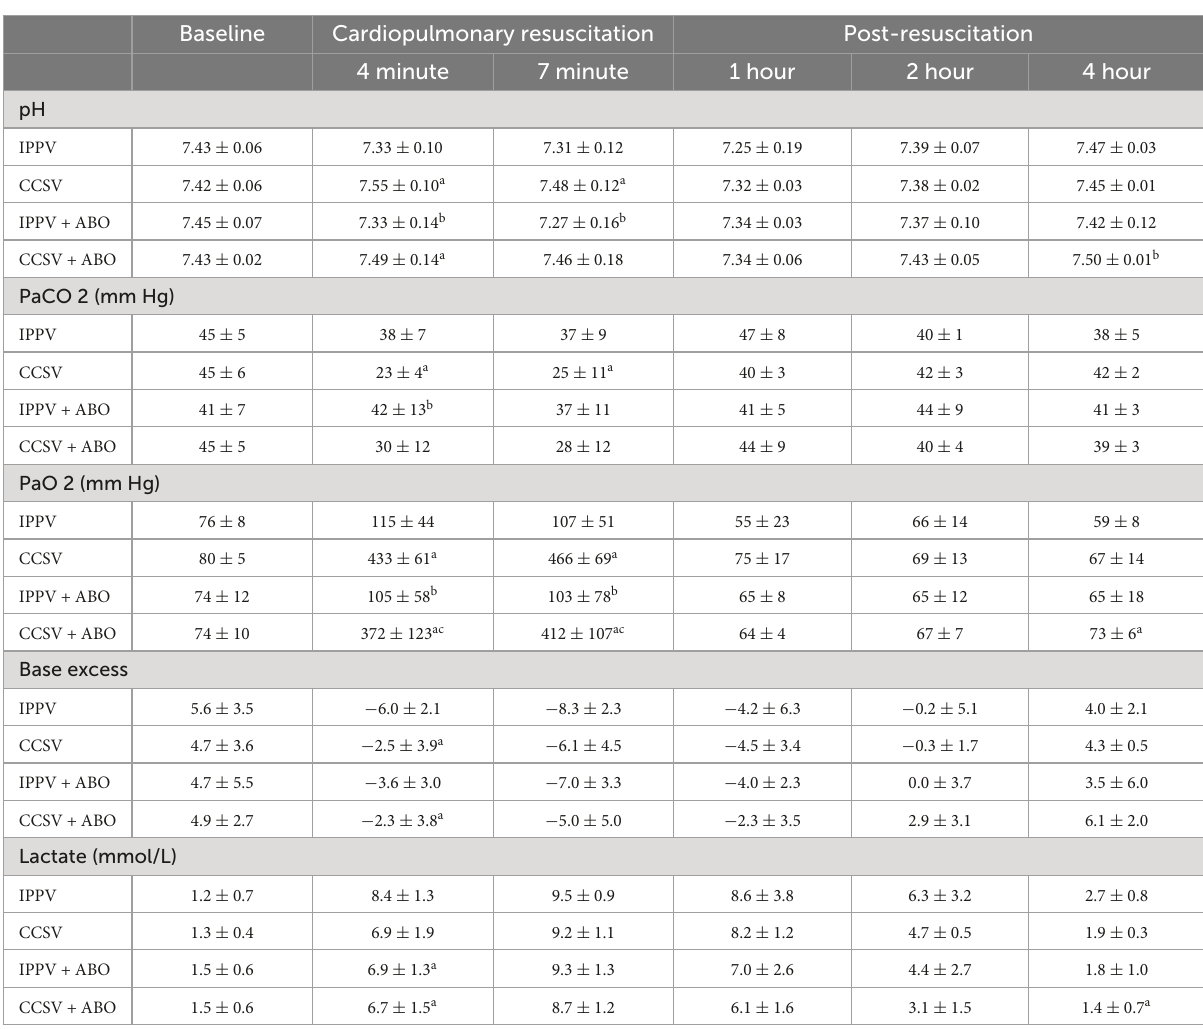
TABLE 2 Arterial blood gas and